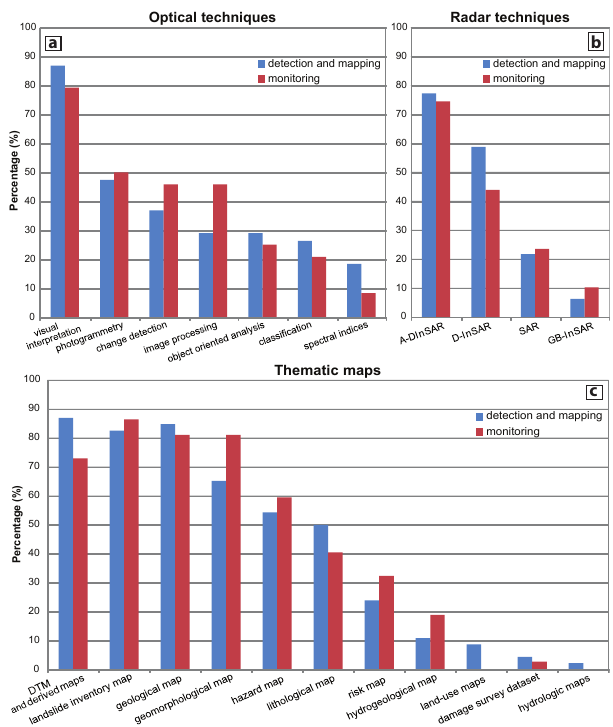
Fig. 3. (a) Optical techniques employed in landslide study. (b) Radar techniques employed in landslide study. (c) Integration of remote sensing data with other thematic data for landslide